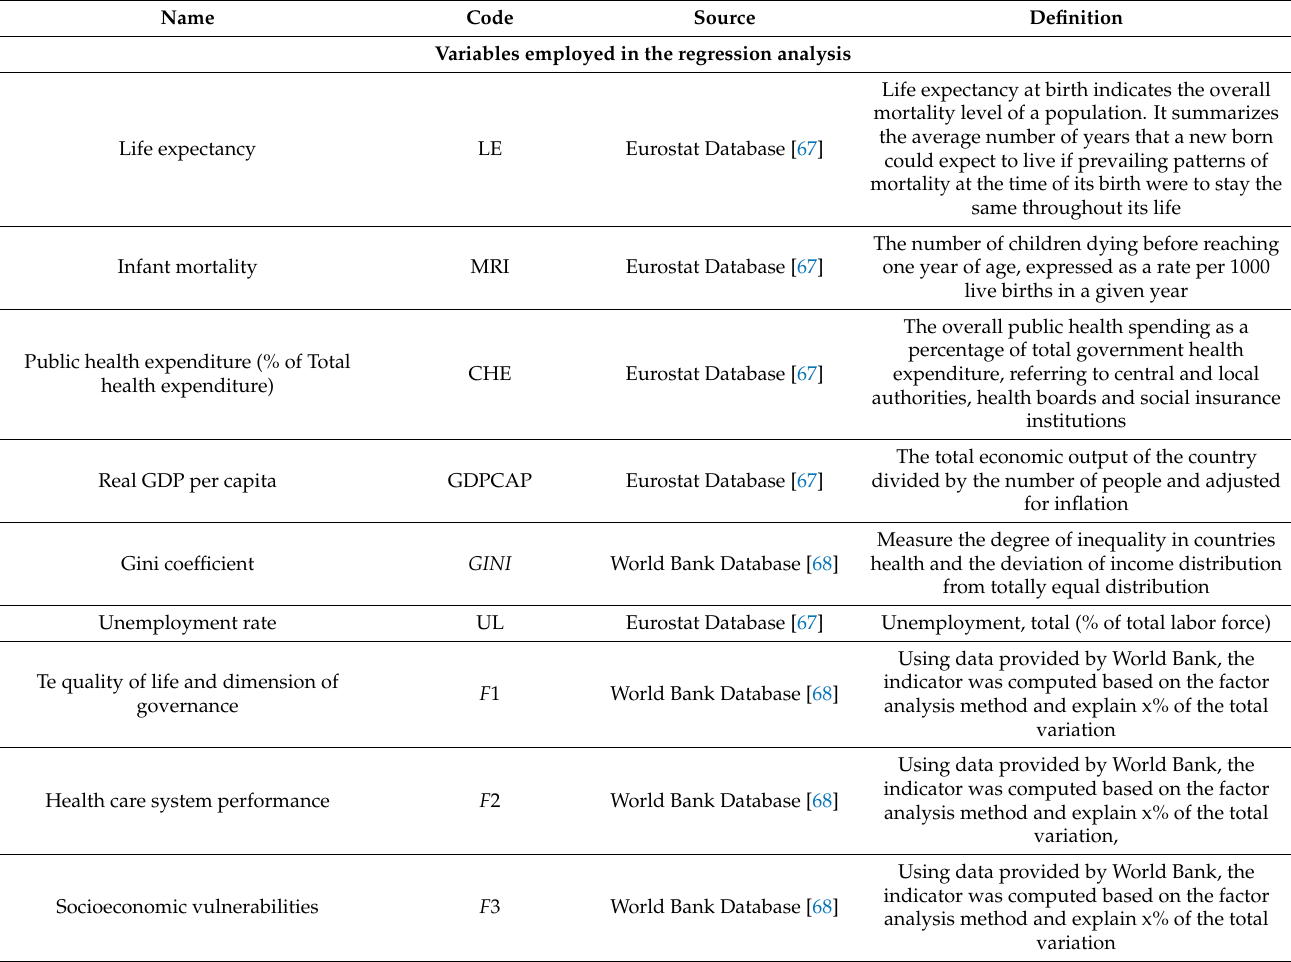
Table A1. The results of mixed-effect